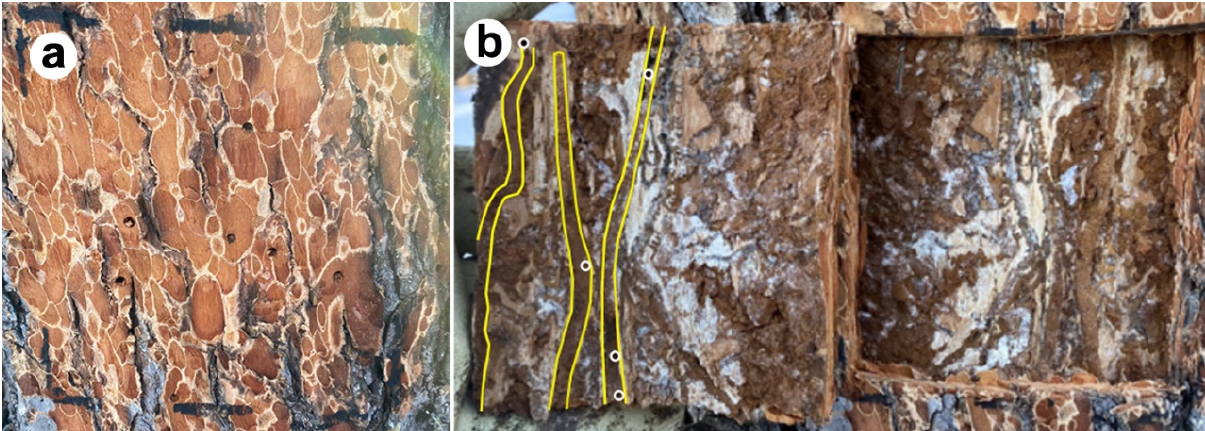
Figure 1. Measured attributes of Douglas-fir beetle (DFB) attack density in Douglas-fir. The number of external beetle holes ( a ) varied the most as some did not penetrate the phloem. The number of phloem-penetrating holes (( b ), white circles) varied the least but were commonly associated with parental breathing holes or new adult exit holes instead of parent gallery initiation. Therefore, the number of vertical galleries (( b ), yellow lines) was the best attribute to describe DFB attack density.